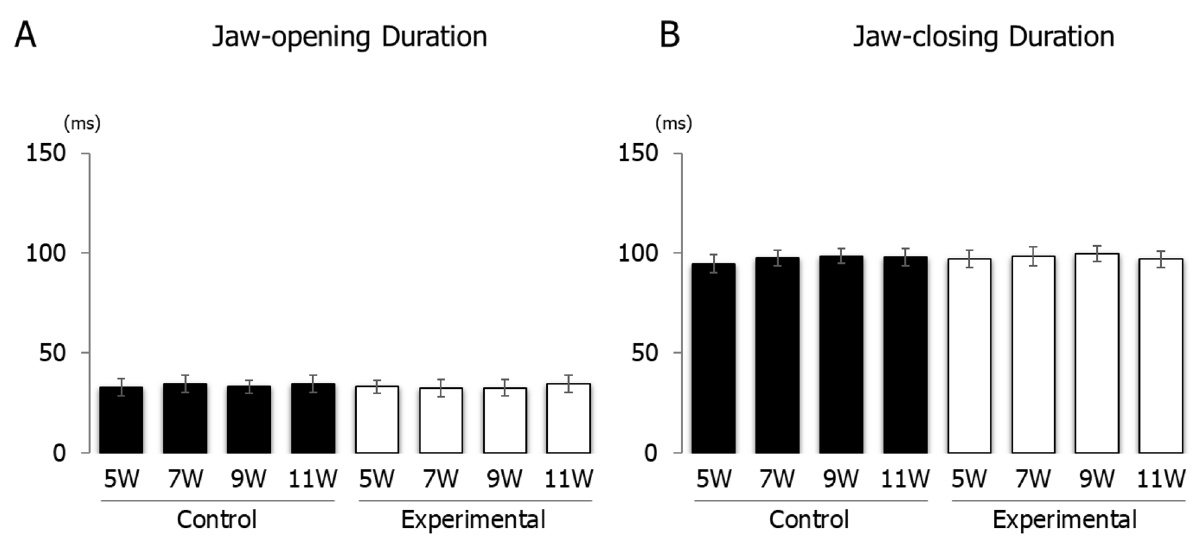
Figure 8. Duration of jaw movement phases during electrical stimulation. Jaw-opening duration ( A ) and jaw- closing duration ( B ) of control and experimental